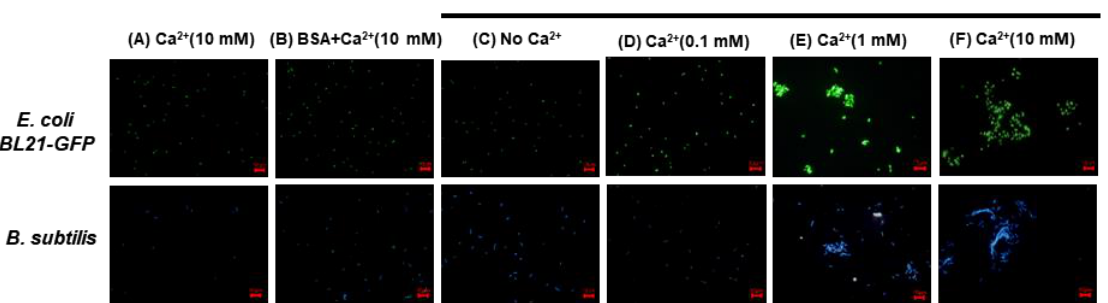
Figure 8. Fluorescence microscopy shows that bacterial agglutination was stimulated by rAbCTLD in both E . coli BL21 and B . subtilis cells in a Ca 2+ -dependent manner. Bacterial agglutination tests were performed on E . coli BL21 – GFP (upper panel) and B . subtilis (lower panel) cells incubated with or without purifi ed rAbCTLD (0.18 μg) in the presence of various concentrations of Ca 2+ . Bacterial cells were incubated with 10 mM Ca 2+ ( A ), or bovine serum albumin (BSA) plus 10 mM Ca 2+ ( B ) in the absence of rAbCTLD. Bacterial cells were incubated with 0 mM ( C ), 0.1 mM ( D ), 1 mM ( E ), or 10 mM ( F ) of Ca 2+ in the presence of rAbCTLD. (scale bar : 10  m)